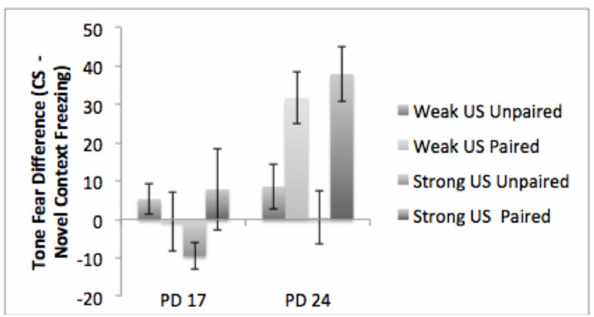
Figure 4. The results of Experiment 2 – auditory conditioning. Only PD 24 subjects exposed to paired CS-US presentations demon- strated subsequent enhanced freezing to the tone, regardless of shock intensity. PD 17 subjects and unpaired PD 24 subjects showed no effect of prior